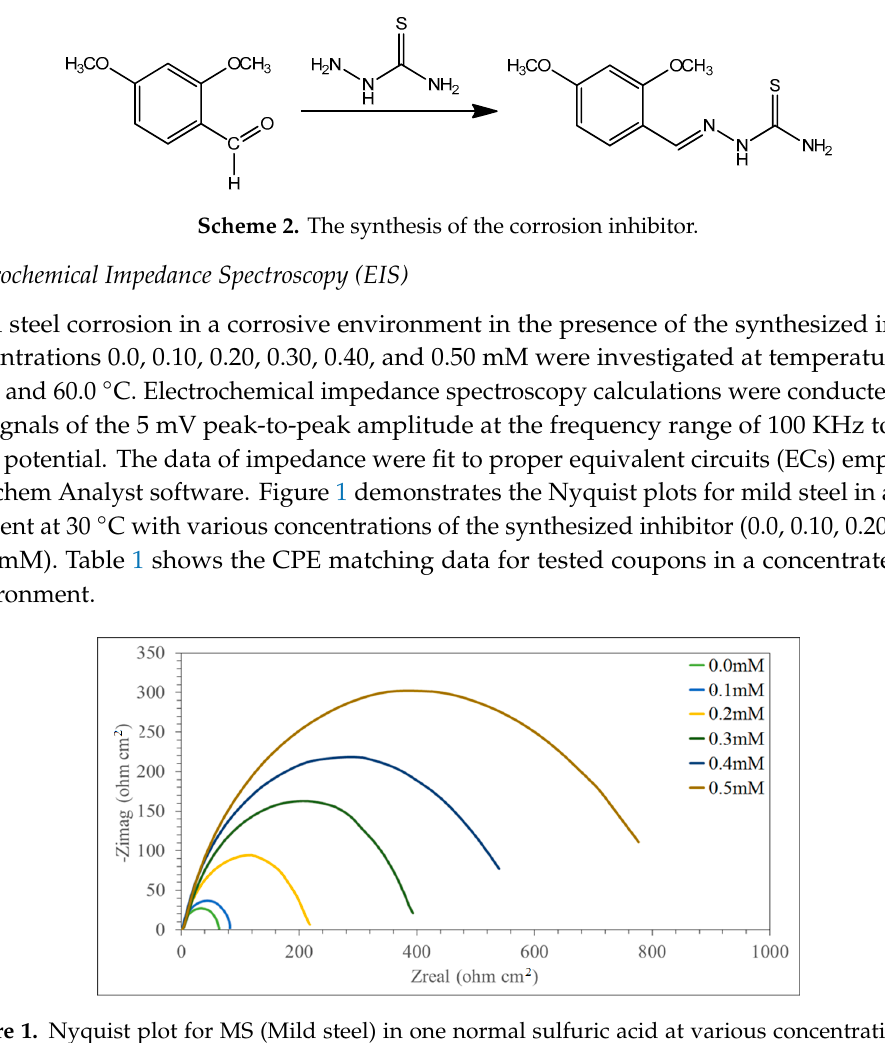
Table 1. CPE (constant phase element) data matching that of MS in a corrosive solution with various concentrations of the DMBHC at 30 °C.